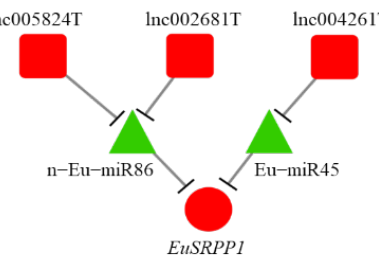
Figure 7. The lncRNA − miRNA − mRNA networks in the pericarp of E. ulmoies during Eu − rubber biosynthesis. Triangles, round rectangles, and circular nodes represent miRNAs, lncRNAs, and mRNAs, respectively. Red and green colors indicate up − and downregulated RNAs in comparison to GZ511 vs. GB511.